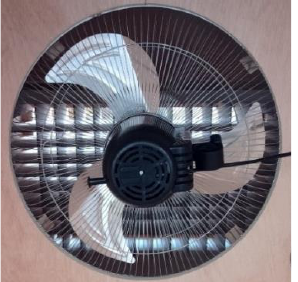
Figure 8. Oscillating 3-speed